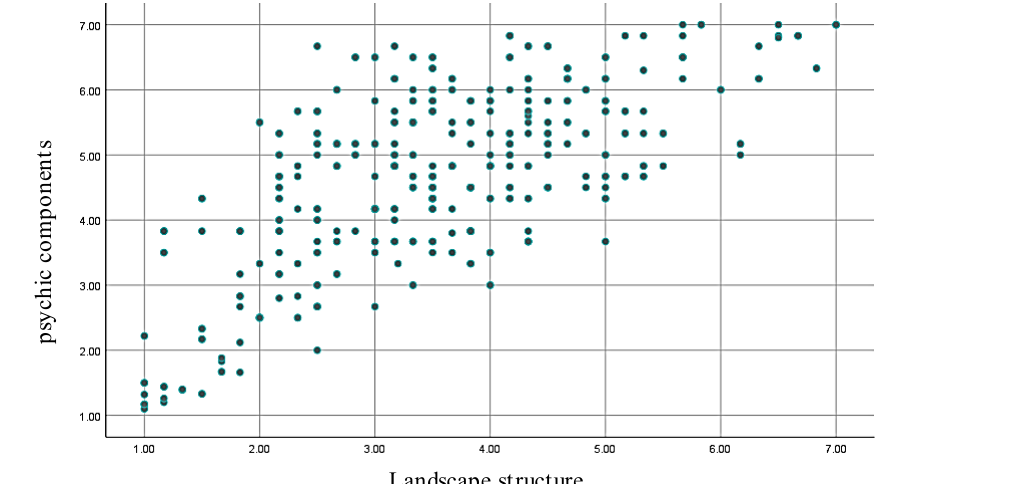
Figure 13. The dispersal chart of landscape structure and mental components Figure 13: The Dispersal Chart of Landscape Structure and Mental